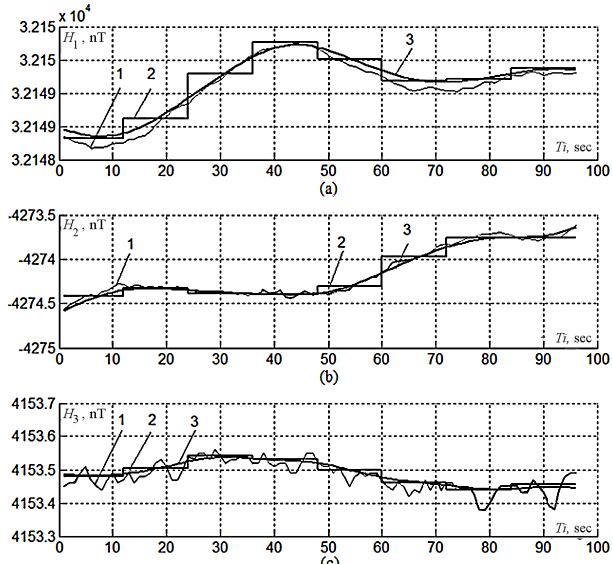
Figure 2. Results of testing the processing algorithm on observatory measurement data: 1 – initial data, 2 – first-stage result ( piecewise constant model estimates without sliding), and 3 – second-stage re- sult (estimates with weighted averaging with